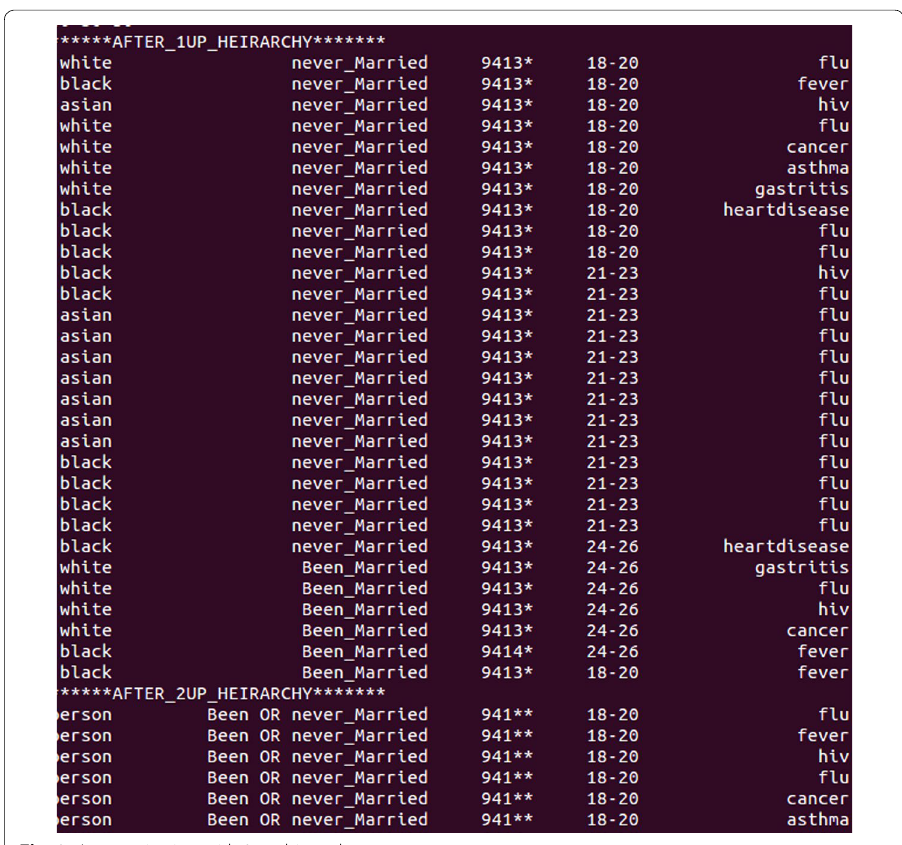
Fig. 9 Anonymization with 2-up hierarchy